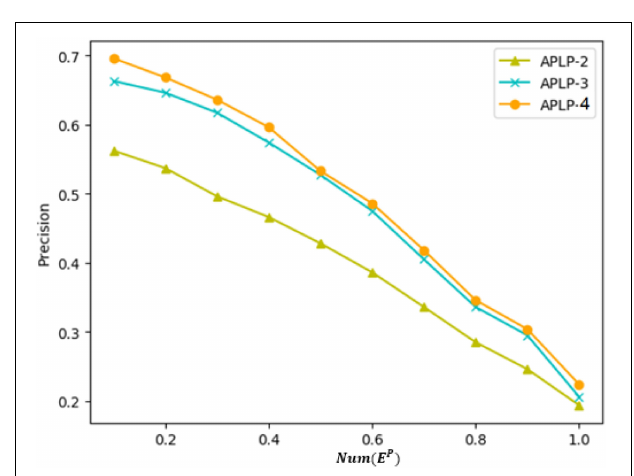
FIGURE 13 | Precision comparison of different models.